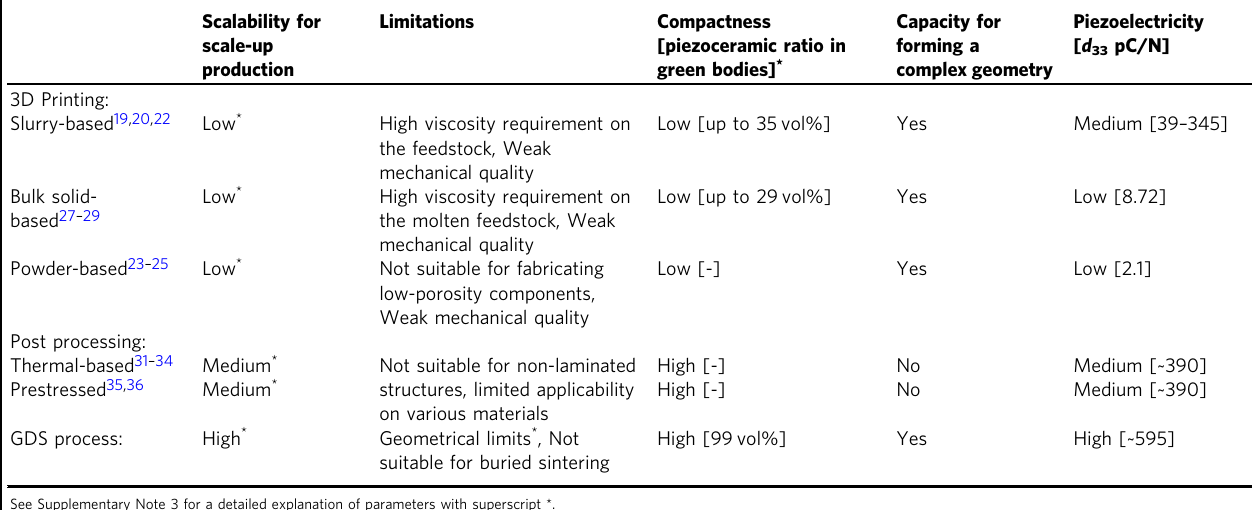
See Supplementary Note 3 for a detailed explanation of parameters with superscript *. [-] denotes that this parameter has not been mentioned in the corresponding reference.